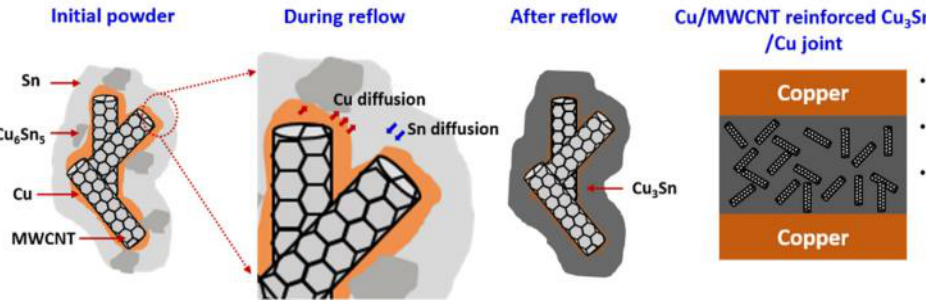
Figure 6. Schematic illustration of TLP bonding using Sn-Cu coated multi-walled CNTs [8].